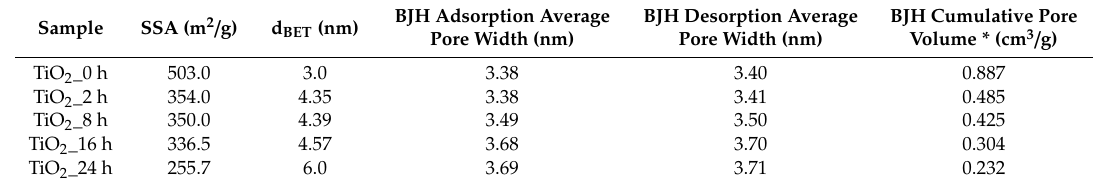
Table 3. Specific surface area (SSA) (by BET method) and porosity values of TiO 2 samples. Sample